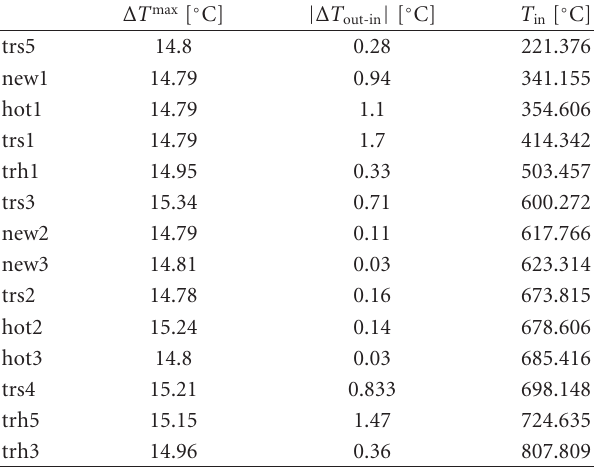
Table 2: Parameters for FCC